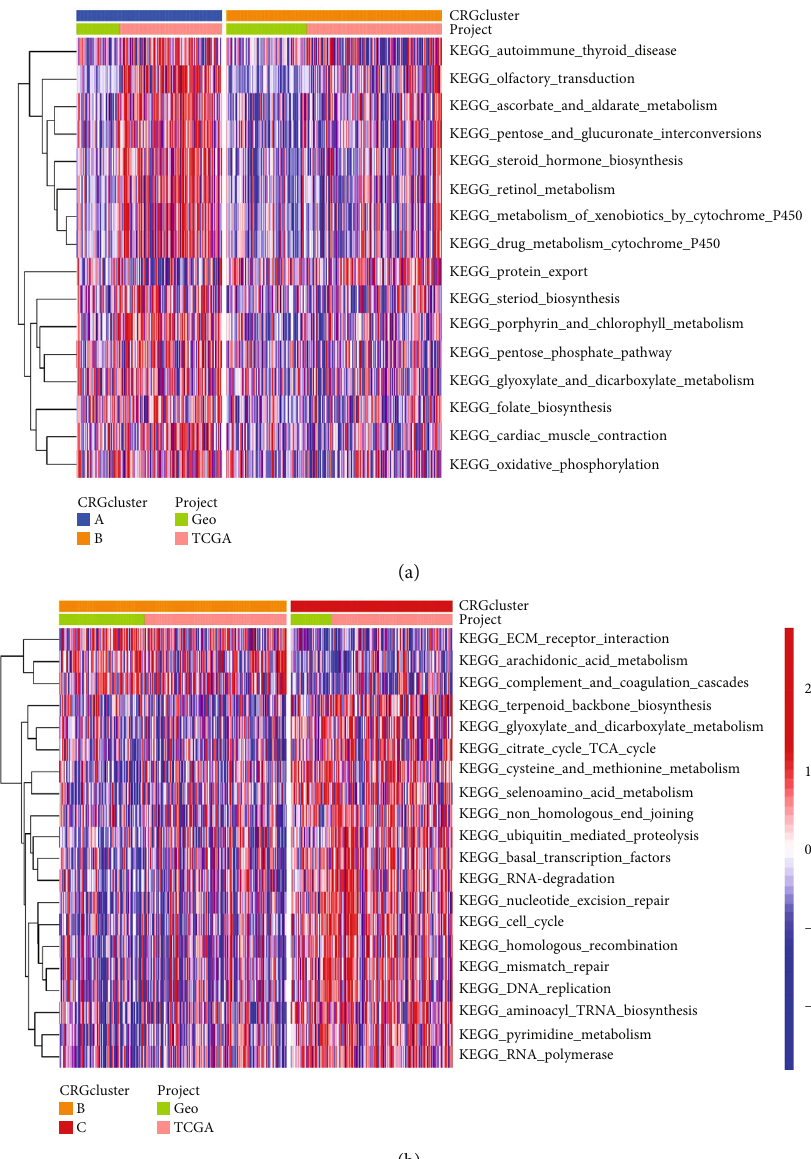
Figure 3: GSVA between distinct CRG subclusters. (a) An examination of the GSVA between clusters A and B. (b) An examination of the GSVA between clusters B and C. GSVA: gene set variation analysis; CRG: cuproptosis-related